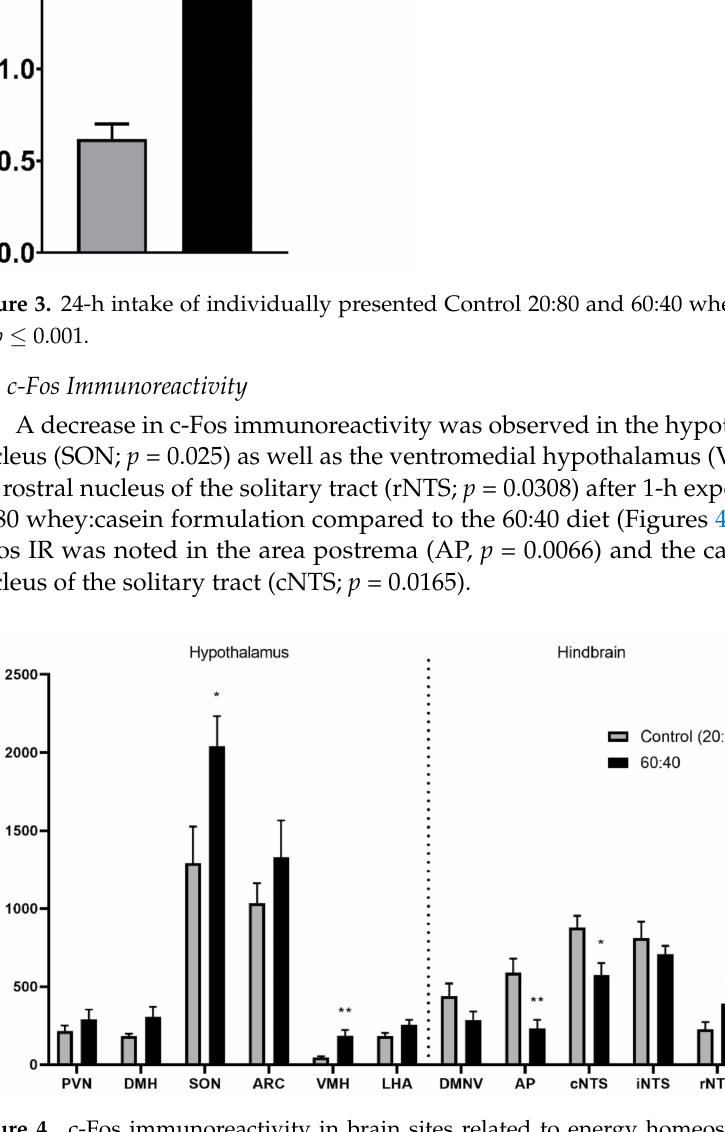
Figure 4. c-Fos immunoreactivity in brain sites related to energy homeostasis increased in the supraoptic nucleus (SON), ventromedial hypothalamus (VMH) and rostral nucleus of the solitary tract (rNTS) and decreased in the area postrema (AP) and caudal nucleus of the solitary tract (cNTS) following the intake of the 60:40 versus control 20:80 whey:casein formulation in mice that ingested 0.35 g (ca. 1 g/g body weight) of the fluid during a 1-h session. PVN–paraventricular nucleus; DMH–dorsomedial hypothalamic nucleus; ARC–arcuate nucleus; LHA–lateral hypothalamic area; DMNV–dorsal motor nucleus of the vagus; iNTS–intermediate nucleus of the solitary tract; * p ≤ 0.05; ** p ≤